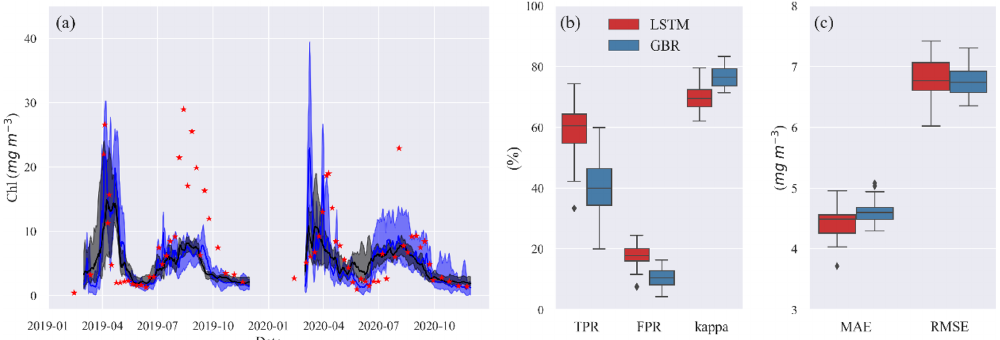
Figure 4. (a) Time series of observed (red stars) and predicted Chl from GBR (black) and LSTM (blue) models in the shuffling training year test. The shades represent the range between minimum and maximum prediction, and the solid lines represent the median prediction. Panel (b) shows the box plot of TPR, FPR, and kappa, and panel (c) shows the box plot of MAE and RMSE of both models in the shuffling training year test.